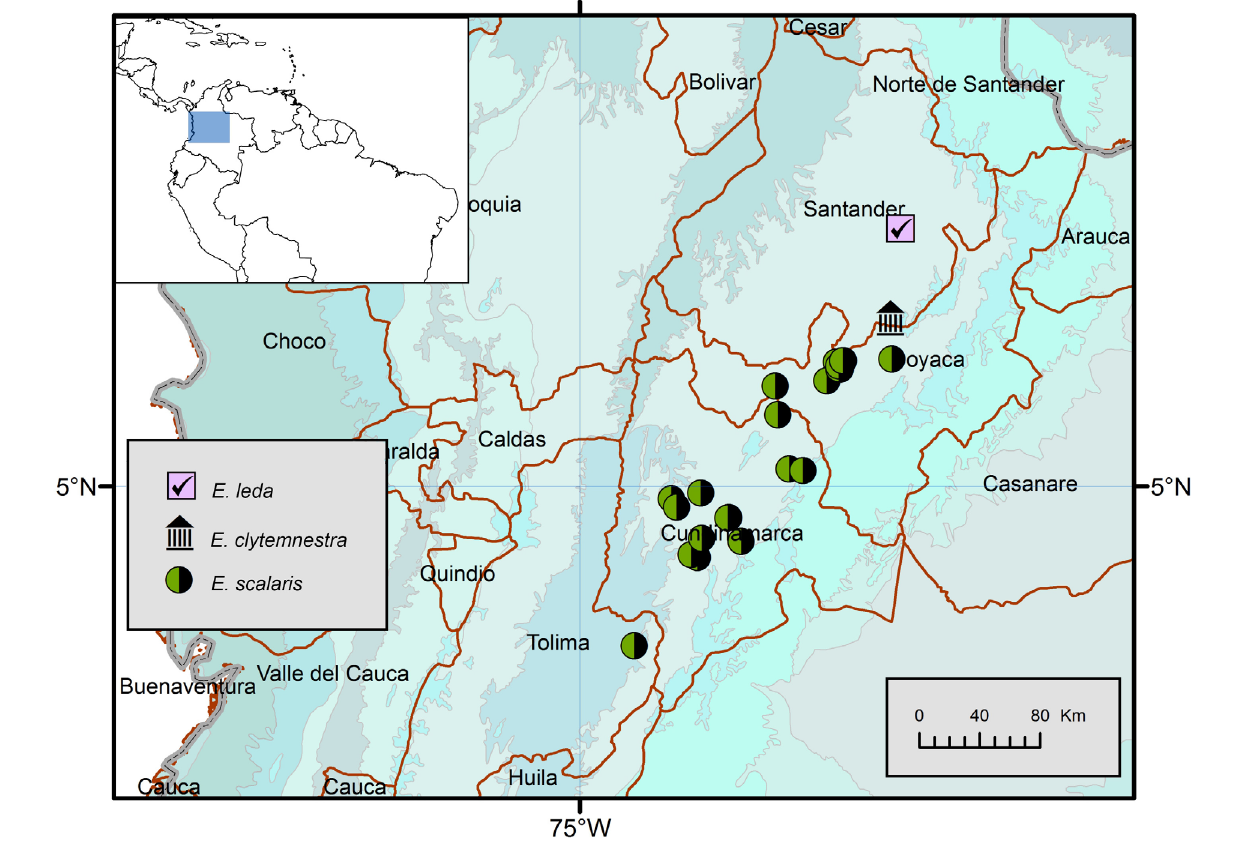
Fig. 33. Northern Andes in Colombia, showing localities for Eulibitia leda sp. nov., E. clytemnestra sp. nov. and E. scalaris (Sørensen in Henriksen, 1932) comb. nov. Colored patches on the background represent WWF